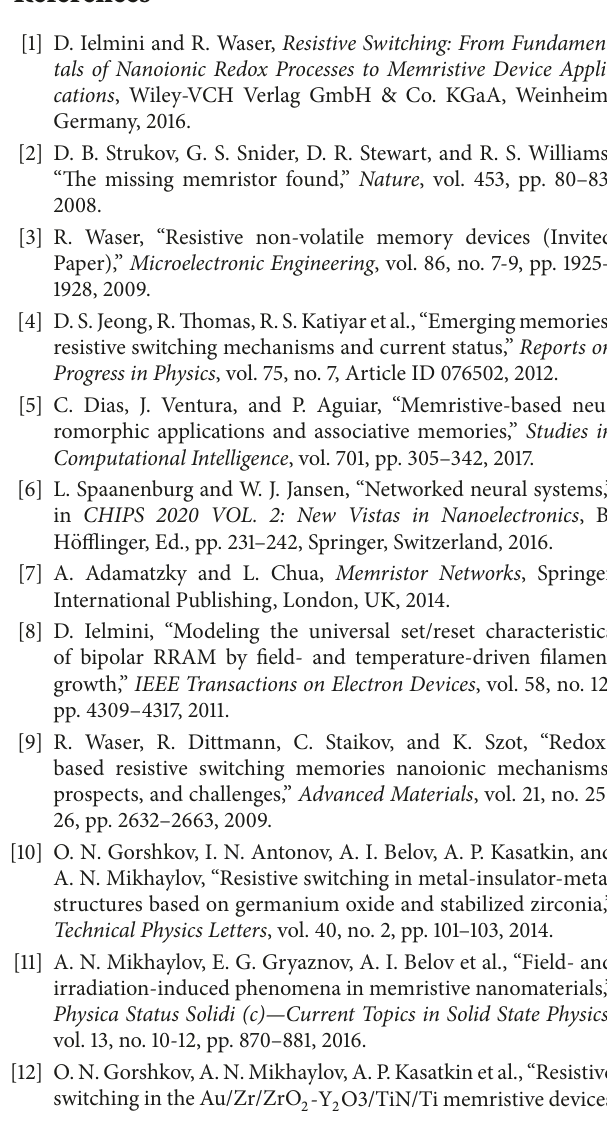
Table 1: The parameters of the oxygen ion transport in the YSZ films in the MOM and MOS stacks determined by various methods. 𝑑 , Sublayer s Substrate nm material TiN/Ti Zr TiN –//– –//– –//– –//– 8 TiN/Ti Ta TiN/Ti Zr 𝑛 -Si –//– –//– 𝑝 -Si Zr –//–